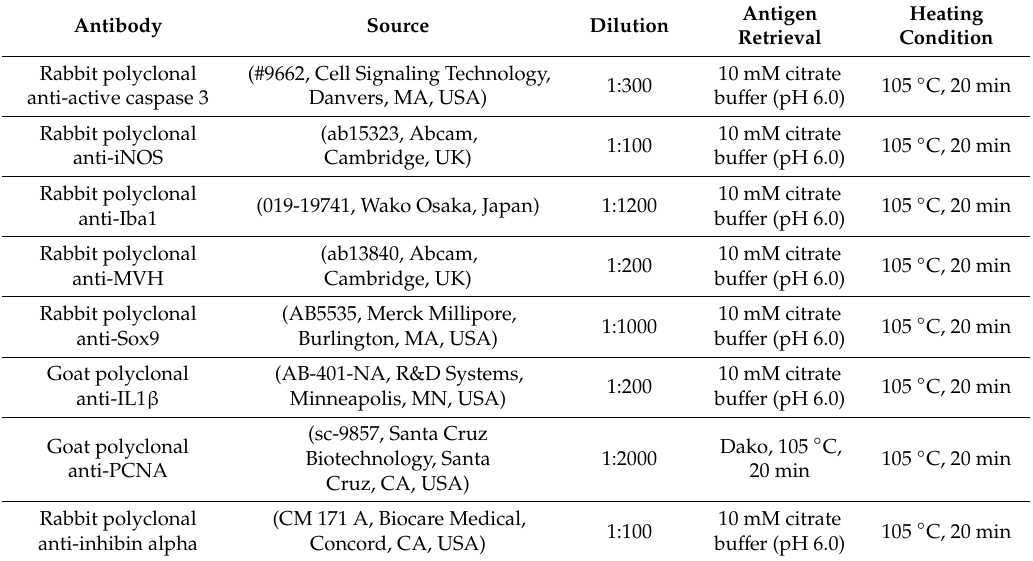
Table 3. List of antibodies, sources, working dilutions, and methods for antigen retrieval. Antibody Source